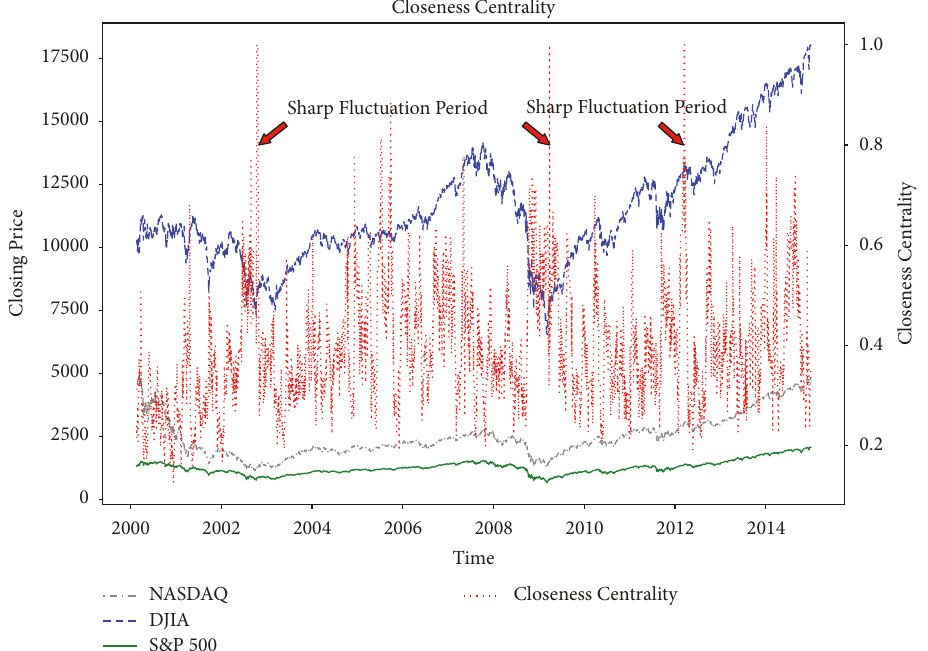
Figure 6: The evolution of the three stock indexes and closeness